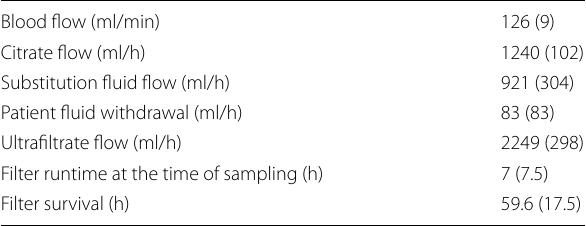
Table 2 Hemofiltration settings at the time of blood